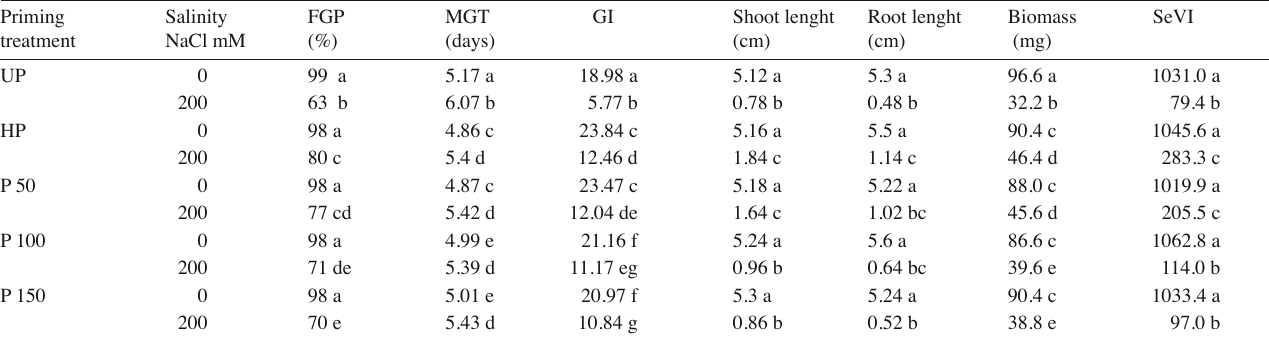
Tab. 2: Effect of priming treatments on the final germination percentage (FGP), mean germination time (MGT), germination index (GI), Shoot and root length,, biomass and seedling vigour index of rice seeds germinated under normal and high salinity condition.